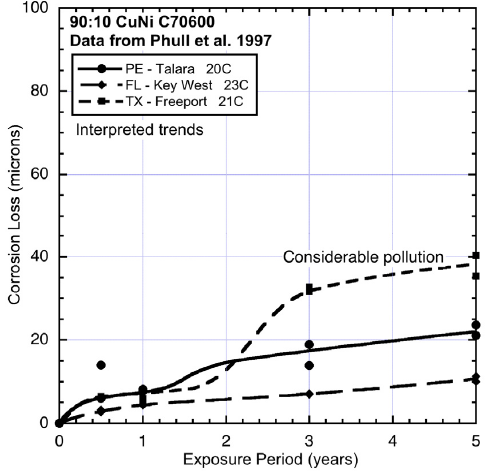
Figure 6. Data and interpreted trends for temperate seawater temperature sites PE, FL and TX.